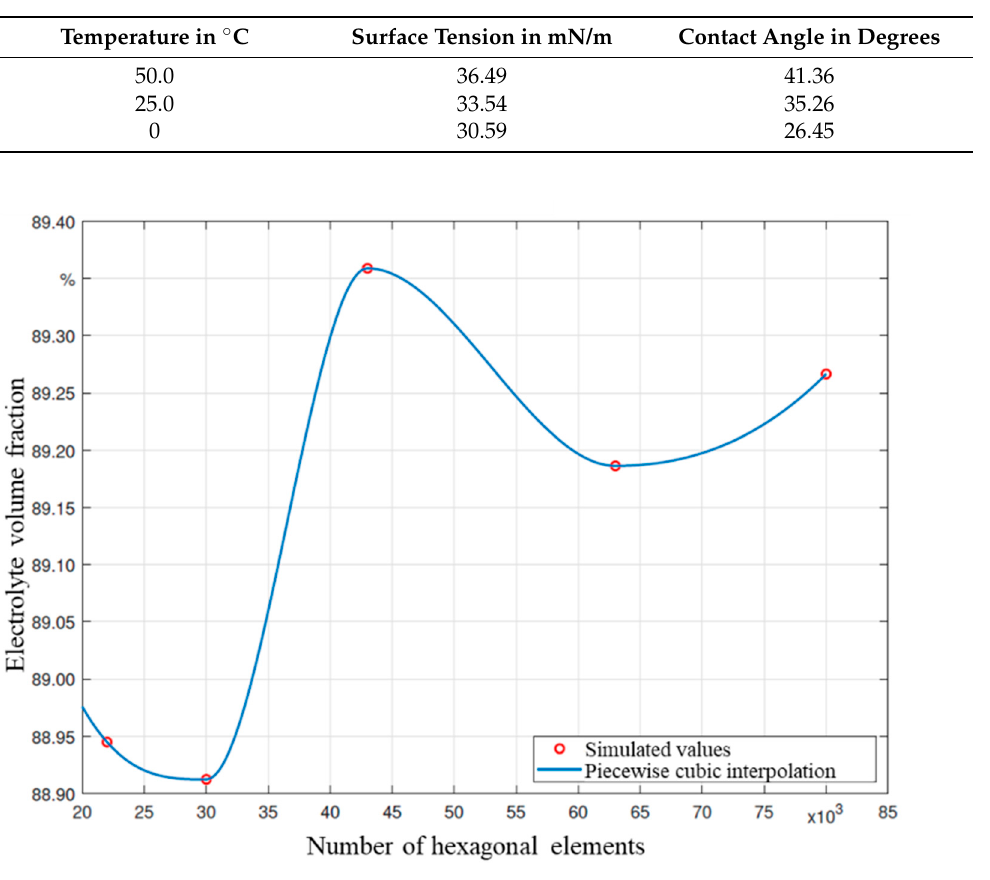
Table A2. Temperature dependent on the surface tension and contact angle of the electrolyte.